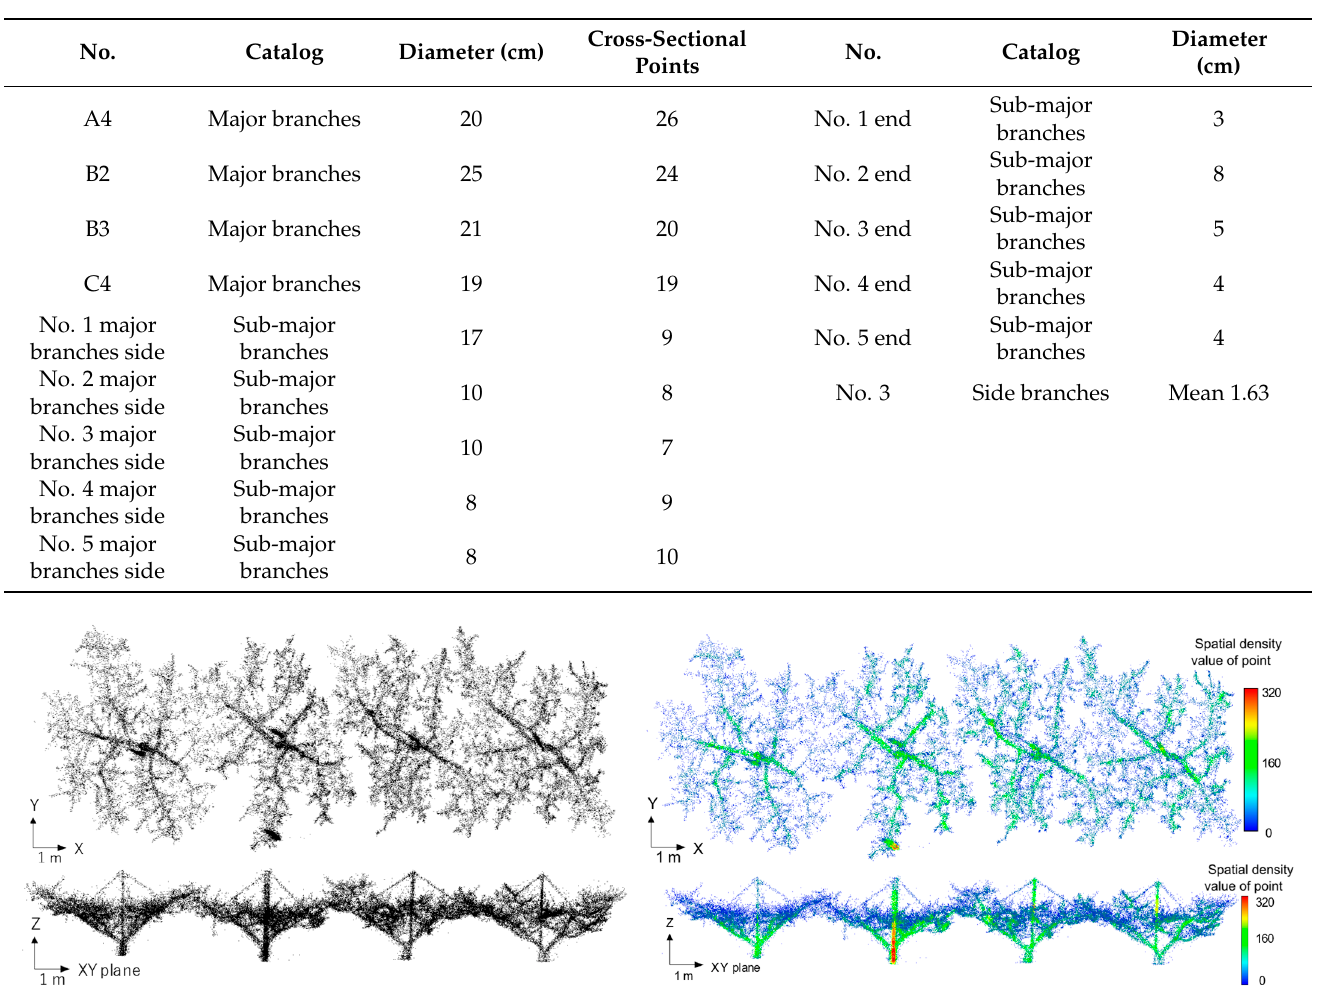
Table 3. Relationship between the branch diameter and cross-sectional points of the 3D point cloud.